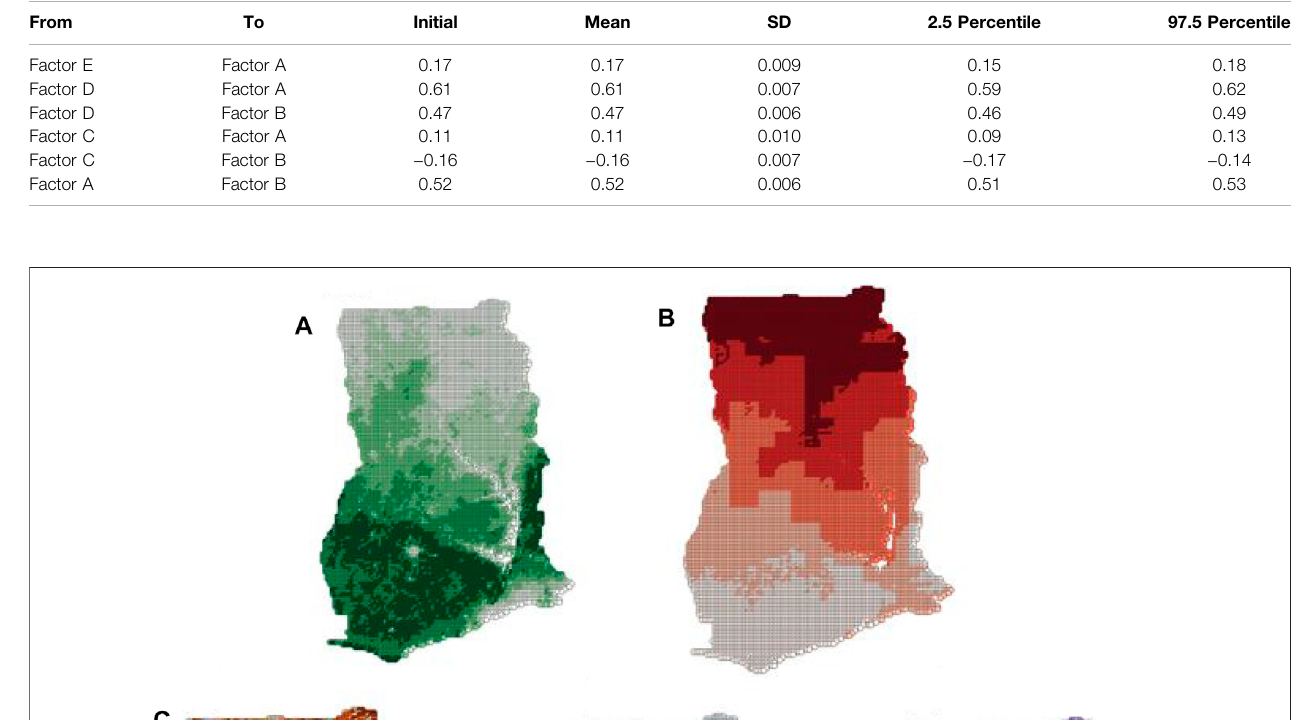
Frontiers in Environmental Science |